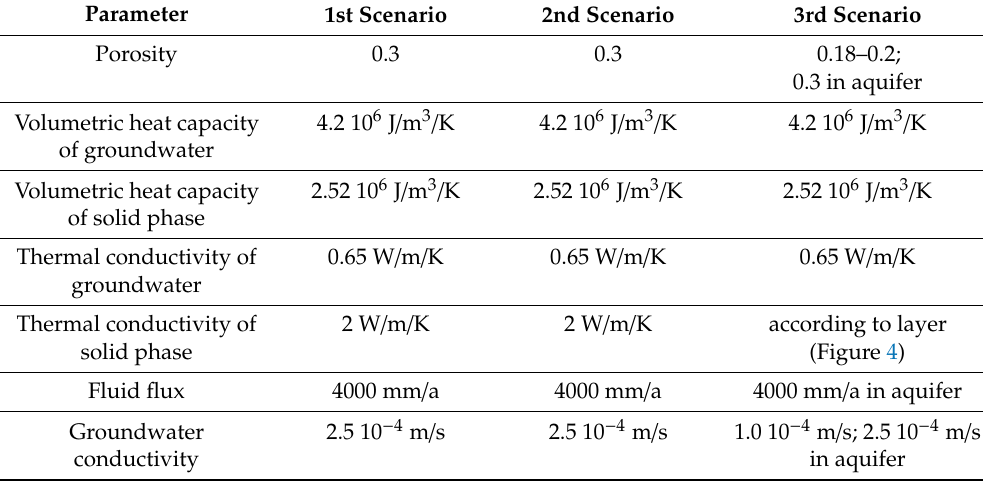
Table 3. Ground and water initial